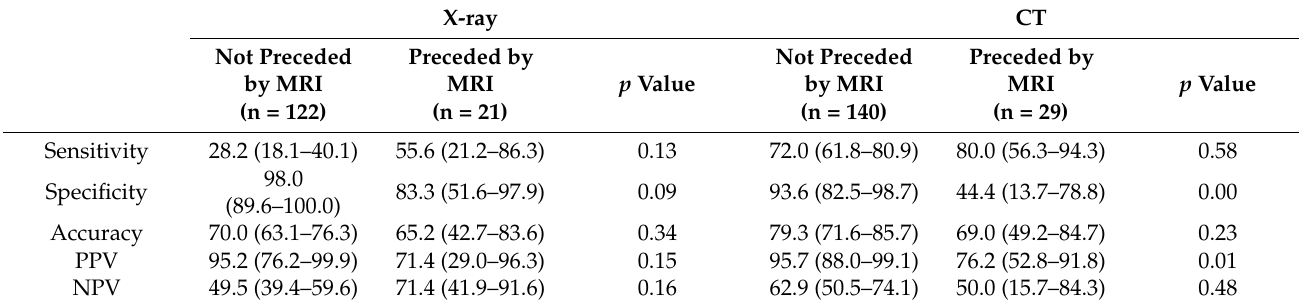
Table 3. Sensitivity, specificity, accuracy, PPV and NPV estimates (reported with 95% confidence intervals) for X-ray and CT without or with access to a preceding MRI.